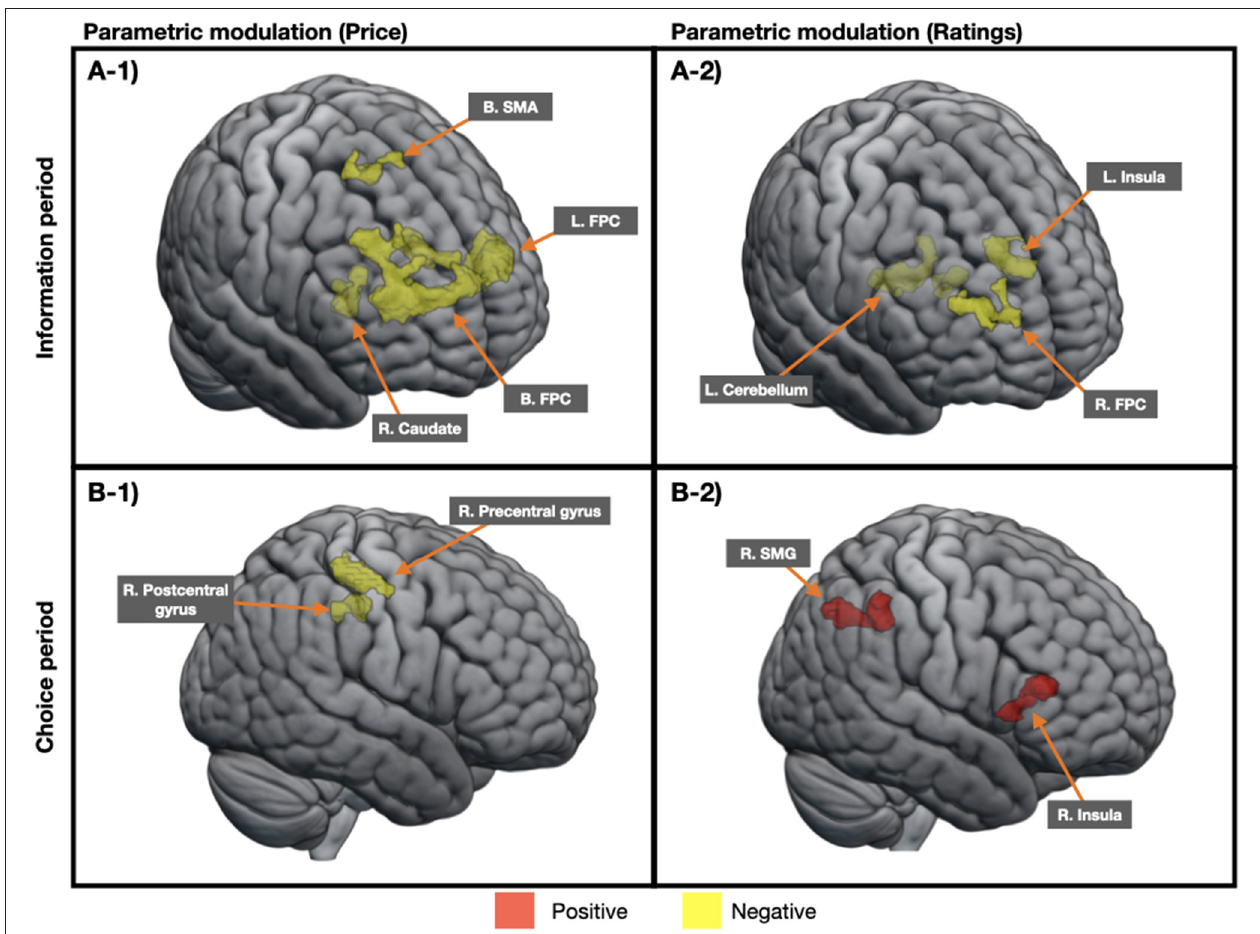
FIGURE 3 | An illustration of regions associated with the intention change scores in parametric modulation analysis. At the information period, regions showing the negative parametric effect were observed in both the price condition (A-1) and rating condition (A-2) . On the contrary, at the choice period, regional activities were negatively modulated in the price condition (B-1) and positively modulated in the rating condition (B-2) . B, bilateral; L, left; R, right; FPC, frontopolar cortex; SMA, supplementary motor area; SMG, supramarginal